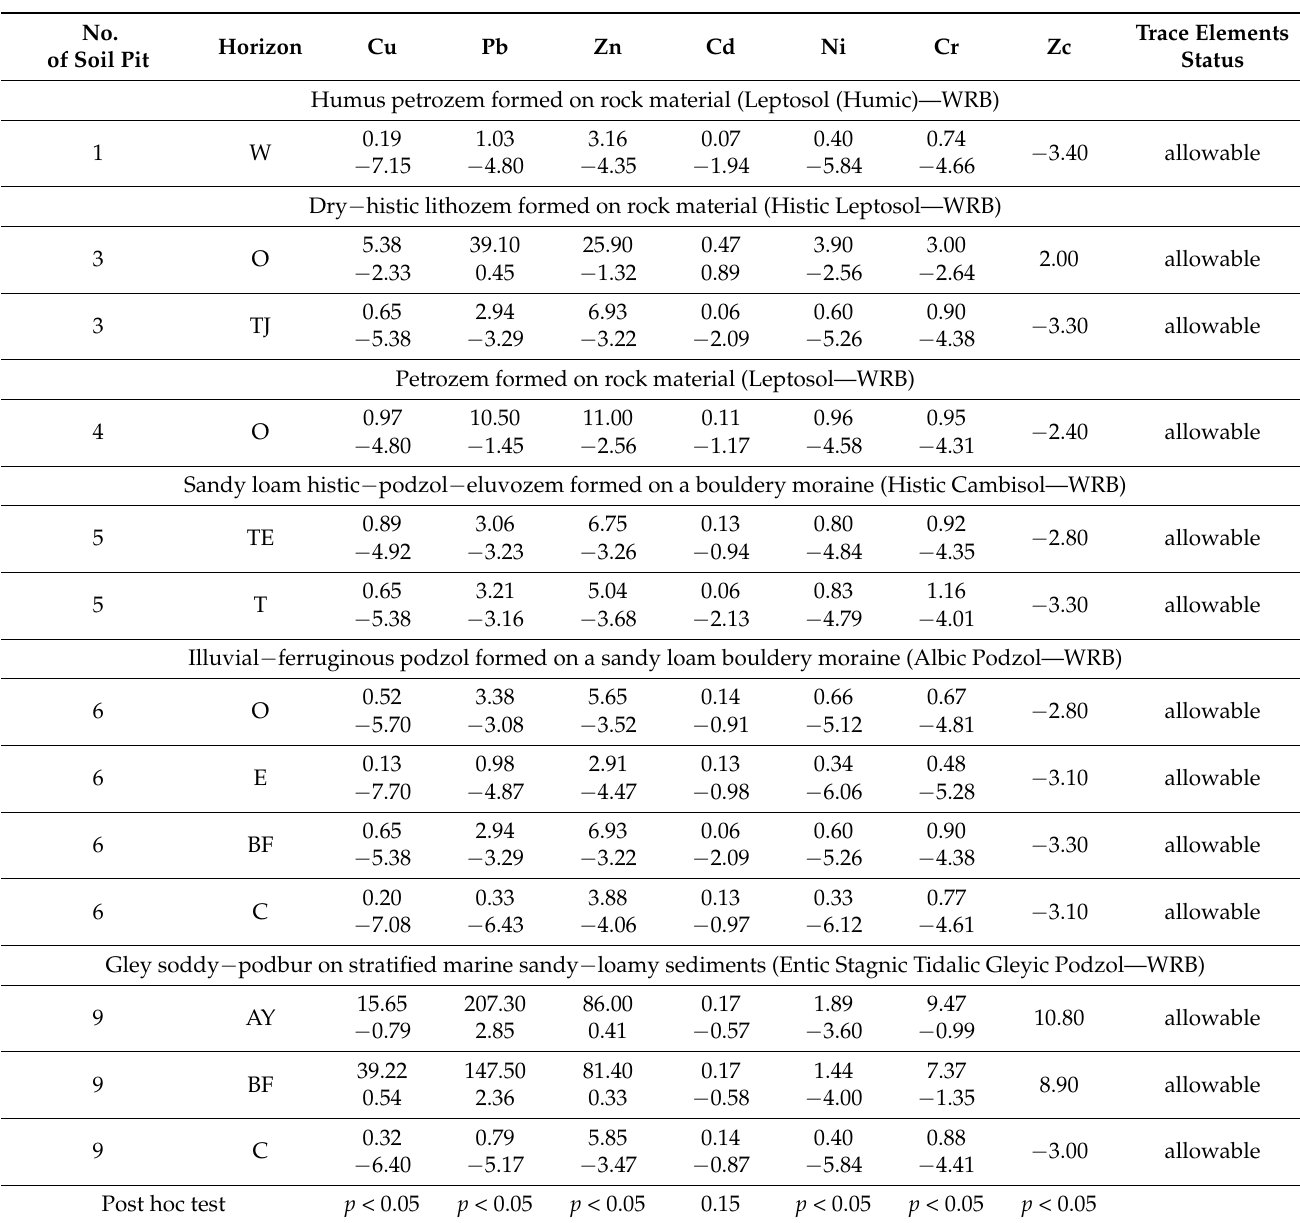
Table 1. Trace elements status of studied soils (numerator is heavy metals content, mg kg − 1 ; denomi- nator is